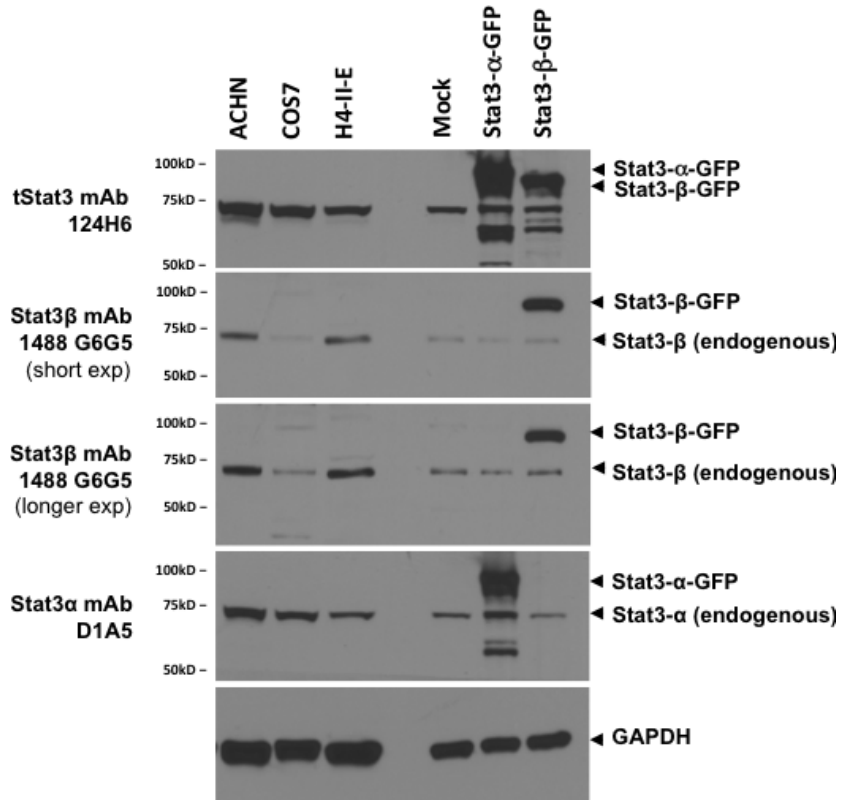
Figure 6. Stat3β monoclonal antibody can detect endogenous Stat3β in lysates from cell lines expressing various levels of Stat3β. Lysates (100 µg of total protein) from cell lines ACHN, COS7, and H4IIE (lanes 1–3) were separated by SDS-PAGE, transferred to nitrocellulose membrane and replicate blots probed for total Stat3 (clone 124H6), Stat3β (516G10H9), Stat3α (Clone D1A5) and GAPDH and visualized by chemiluminiscence. Lysates (30 µg of protein) from 293T cells, mock transfected (transfection reagent alone) or transiently transfected with plasmids encoding fusion proteins Stat3α-GFP and Stat3β-GFP were used as controls (lanes